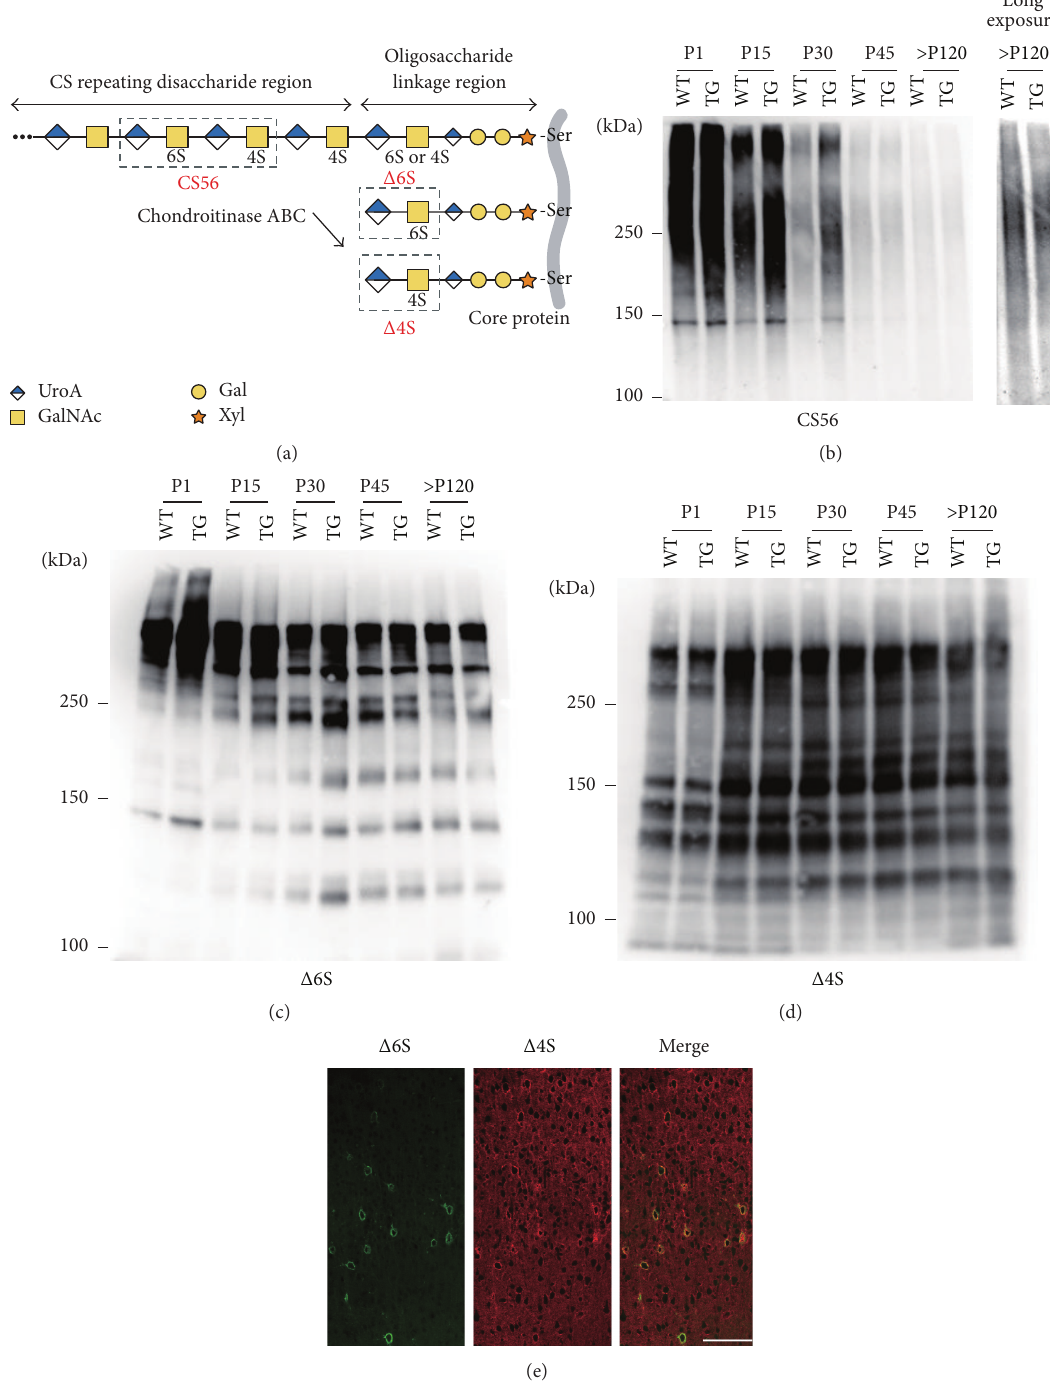
Figure 3: Effects of overexpression of C6ST-1 on the repeating disaccharide region and linkage region of CS chains. (a) Epitopes recognized by antibodies CS56, Δ 6S, and Δ 4S. 6S and 4S represent 6-sulfation and 4-sulfation, respectively. (b) C6ST-1 TG mice showed a delayed decrease in CS56-reactivity as compared with WT in the developing brain. Δ 6S (c) and Δ 4S (d) antibodies recognized distinct subsets of CSPGs. During early postnatal development, C6ST-1 TG mice exhibited greater Δ 6S-reactivity than WT mice, whereas Δ 4S-reactivity was not different between the two groups. (e) Distinct localization of Δ 6S- and Δ 4S-reactive CSPGs in 6-month-old adult cerebral cortex of WT mice. Scale bar, 100 𝜇